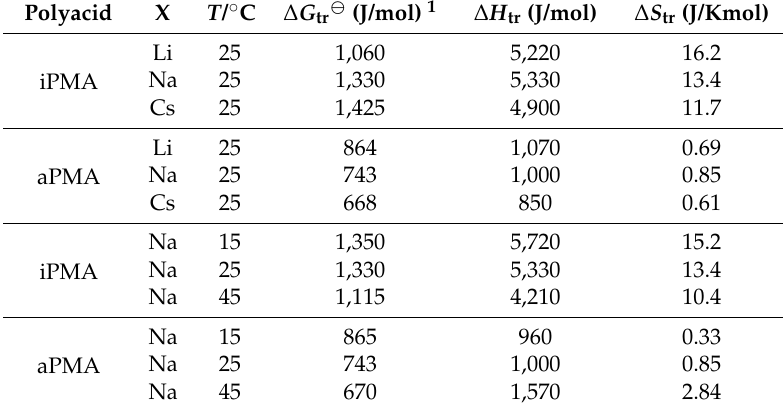
Table 2. Values of the total standard Gibbs free energy change, ∆ G tr , and the enthalpy and entropy (cid:23) changes, ∆ H tr and ∆ S tr , respectively, accompanying the transition of the iPMA and aPMA chains from the compact to the extended form in aqueous 0.01 M XCl solutions (X = Li, Na, Cs) at 15, 25, and 45 ˝ C. Polyacid X T / ˝ C ∆ G tr (J/mol) 1 ∆ H tr (J/mol) ∆ S tr (J/Kmol) (cid:23) Li 25 1,060 5,220 16.2 Na 25 1,330 5,330 13.4 iPMA Cs 25 1,425 4,900 11.7 25 864 0.69 aPMA 15 1,350 5,720 15.2 Na 25 1,330 5,330 13.4